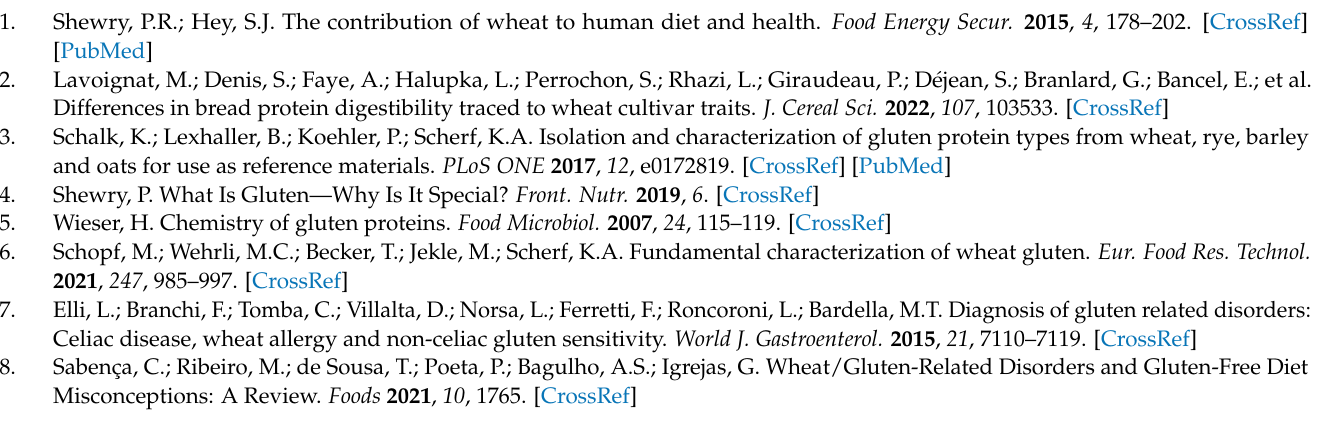
Figure S3: Gluten proteins of the wheat flour V-25 [3], Table S1: Quantification of gliadin proteins in wheat flour fermentation, Table S2: Quantification of gliadin proteins in bread